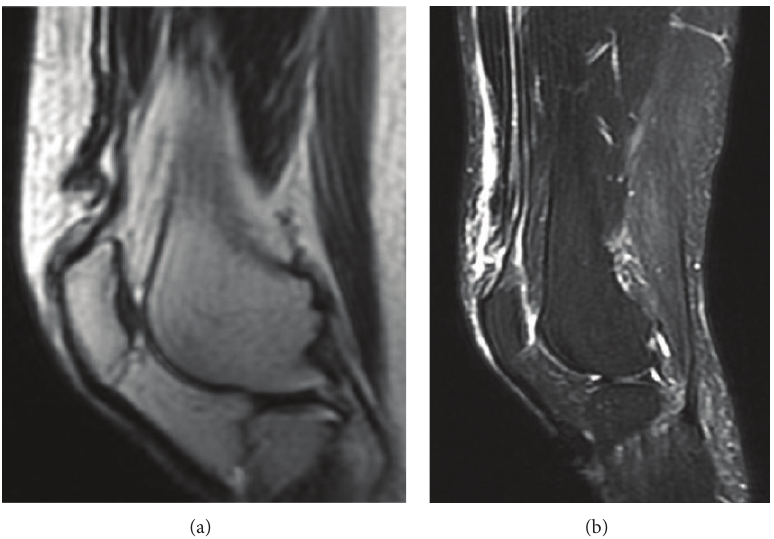
Figure 10: Preoperative MRI image in Case 2. (a) A sagittal proton density-weighted image showing maintained continuity of the deep layer of the quadriceps tendon and patella, in addition to disruption and deflection of the superficial layer. (b) Short tau inversion recovery (STIR) imaging showing the same changes as in